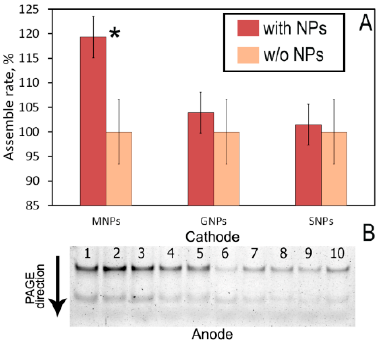
Figure 4. ( A ) Percentage of hybridized siRNA molecules in the presence of NPs. Shown values are an average of 5 repeats in relation to control immediately after mixing of siRNA with NPs. Error bars represent standard deviation. * p < 0.05. ( B ) Image of PAGE gel with (S + As) + MNPs (lanes 1–5) and (S + As) (used as the control, lanes 6–10) immediately after mixing. Upper and lower bands are hybridized and non-hybridized siRNA, respectively.